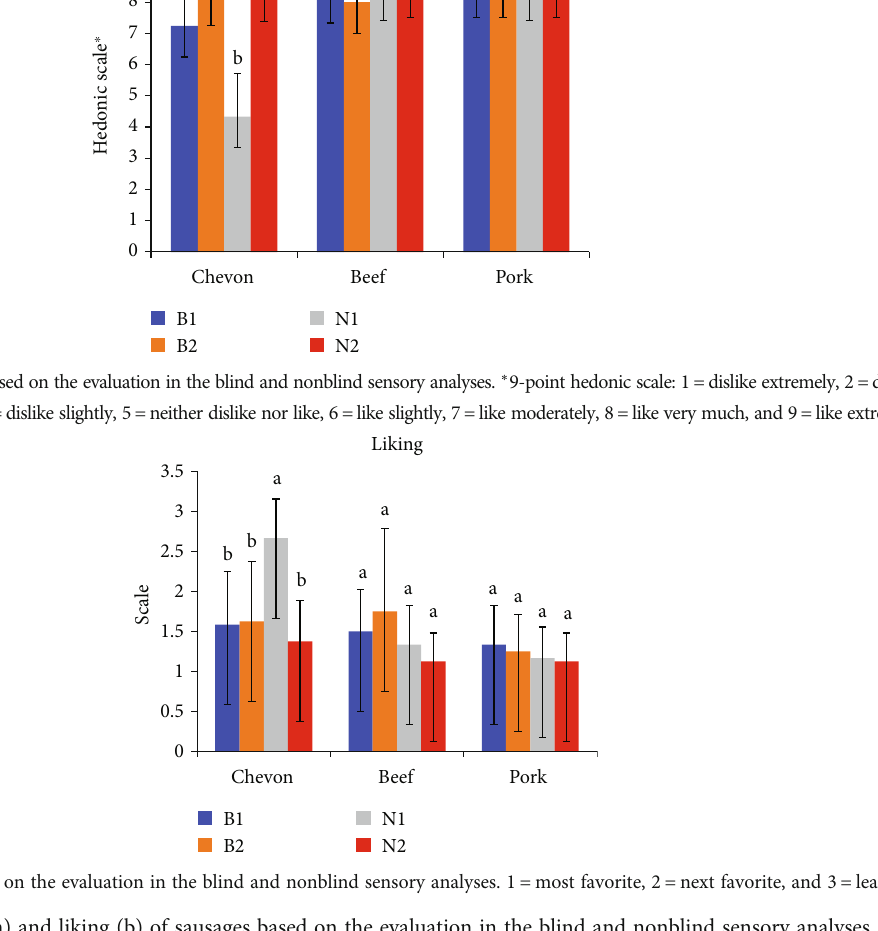
Figure 3: Overall satisfaction (a) and liking (b) of sausages based on the evaluation in the blind and nonblind sensory analyses. a,b Means that are di ff erent on the same sausage indicate signi fi cant di ff erences ( P < 0 : 05 ). B1=South Africans in blind sensory analysis; B2=non- South Africans in blind sensory analysis; N1 =South Africans in nonblind sensory analysis; N2 =non-South Africans in nonblind sensory